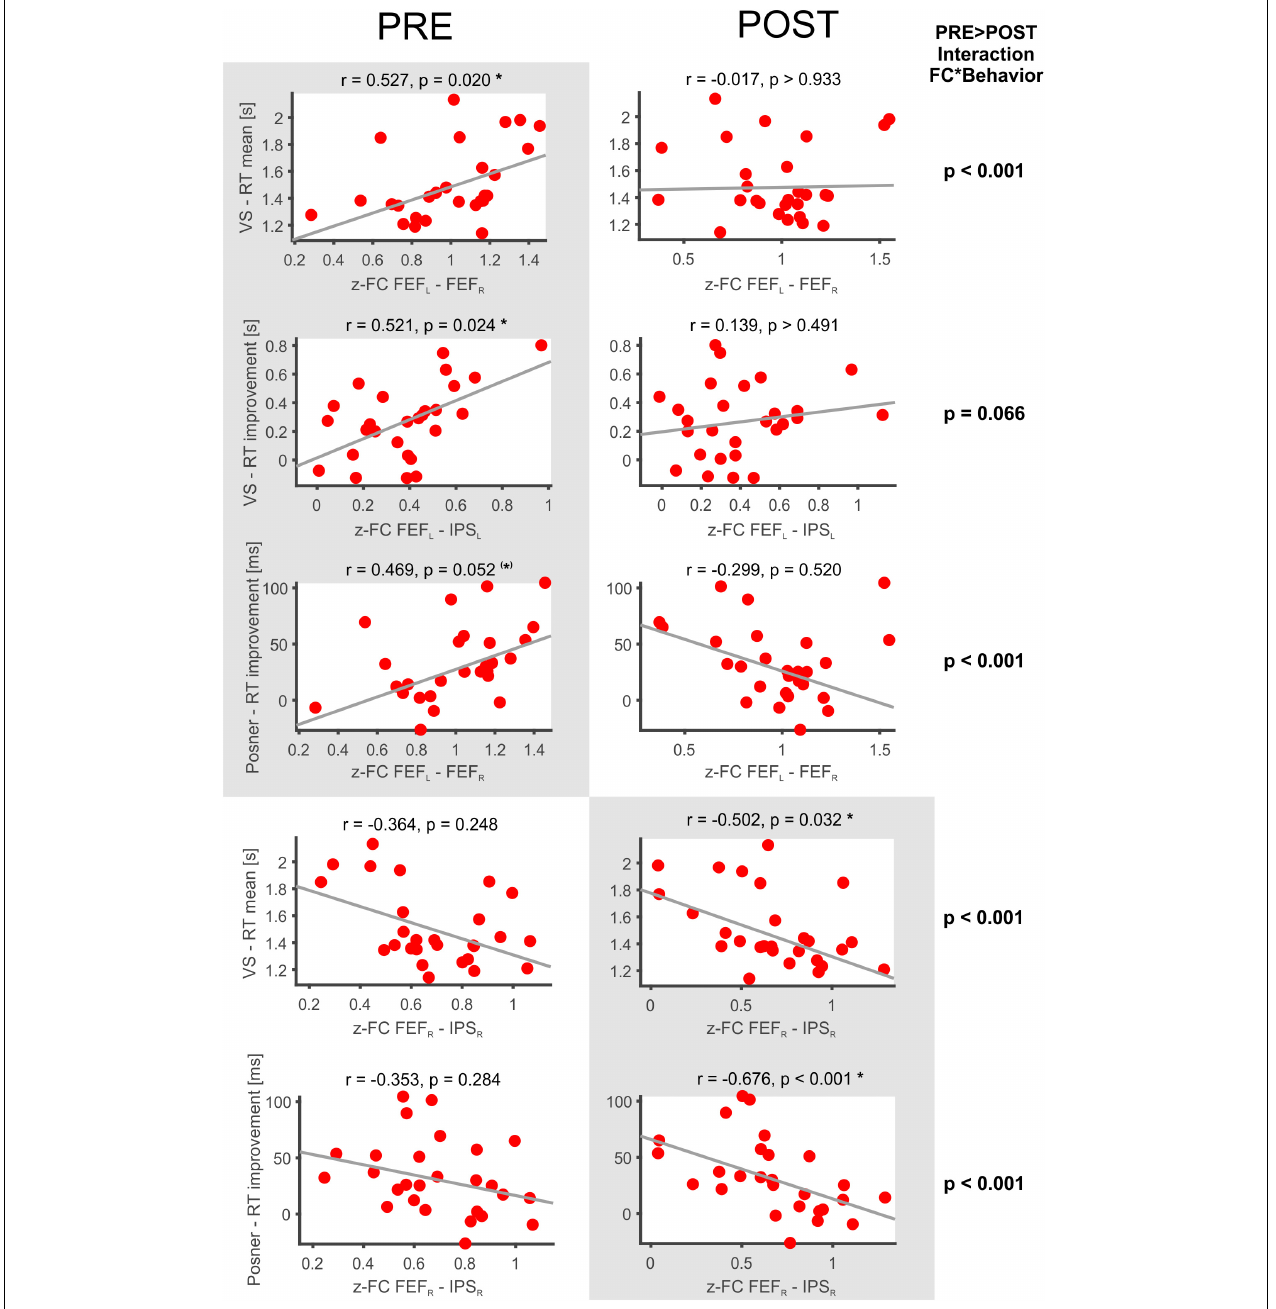
FIGURE 3 | Significant FC-behavior correlations in the PRE and POST rs-fMRI session. The z-transformed FC of several DAN-ROI pairs is correlated with measures of behavioral performance in spatial attentions tasks (mean RT, RT improvement). For each correlation, the Spearman’s rank correlation coefficient ( r ) and a robust fit (gray line) is provided as well as the respective p -value (corrected for multiple comparisons applying Bonferroni–Holm). Significant correlations are highlighted on a gray background and marked with * (corrected p < 0.05) or (*) for a statistical trend ( p < 0.1), while the non-significant counterparts in the PRE or POST condition are shown beside on a white